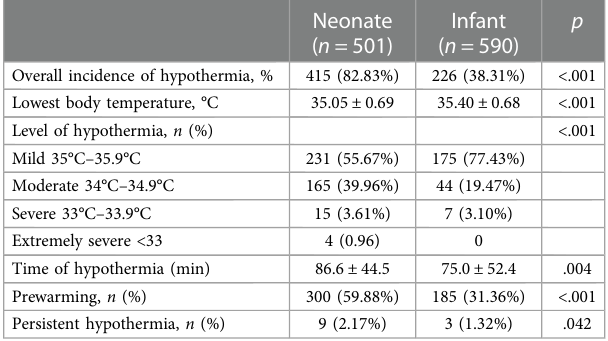
TABLE 1 Characteristics of hypothermia in neonates and